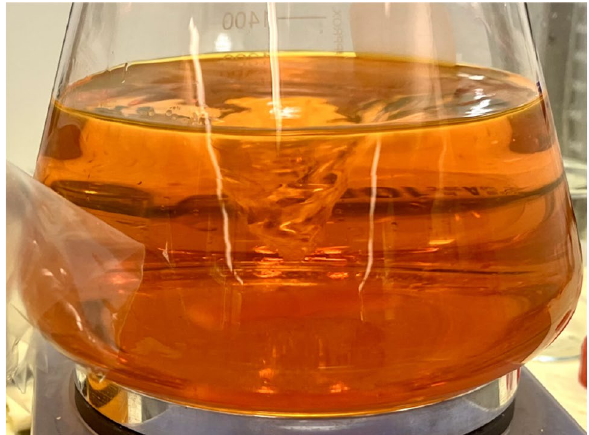
Figure 2. Sample Sipdril 4/0 stained with Nile red on a magnetic hot plate